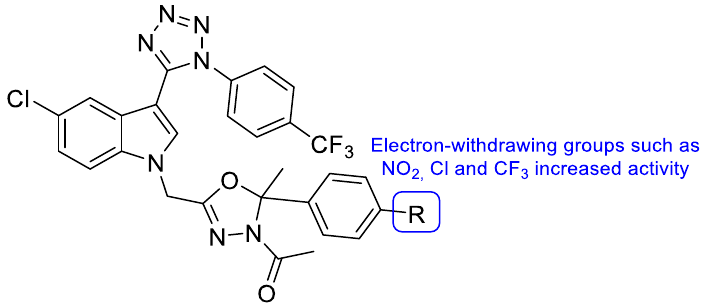
Figure 42. Chemical structure of the tetrazole-pyrazole compounds and SAR [107].